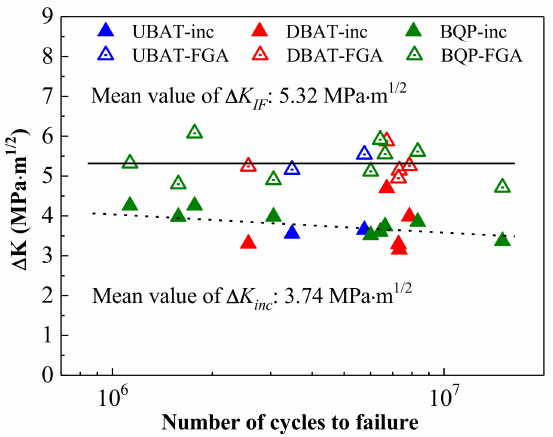
Figure 7. Stress intensity factor range of inclusion and the inclusion-induced FGA (IF) of bainitic steels.